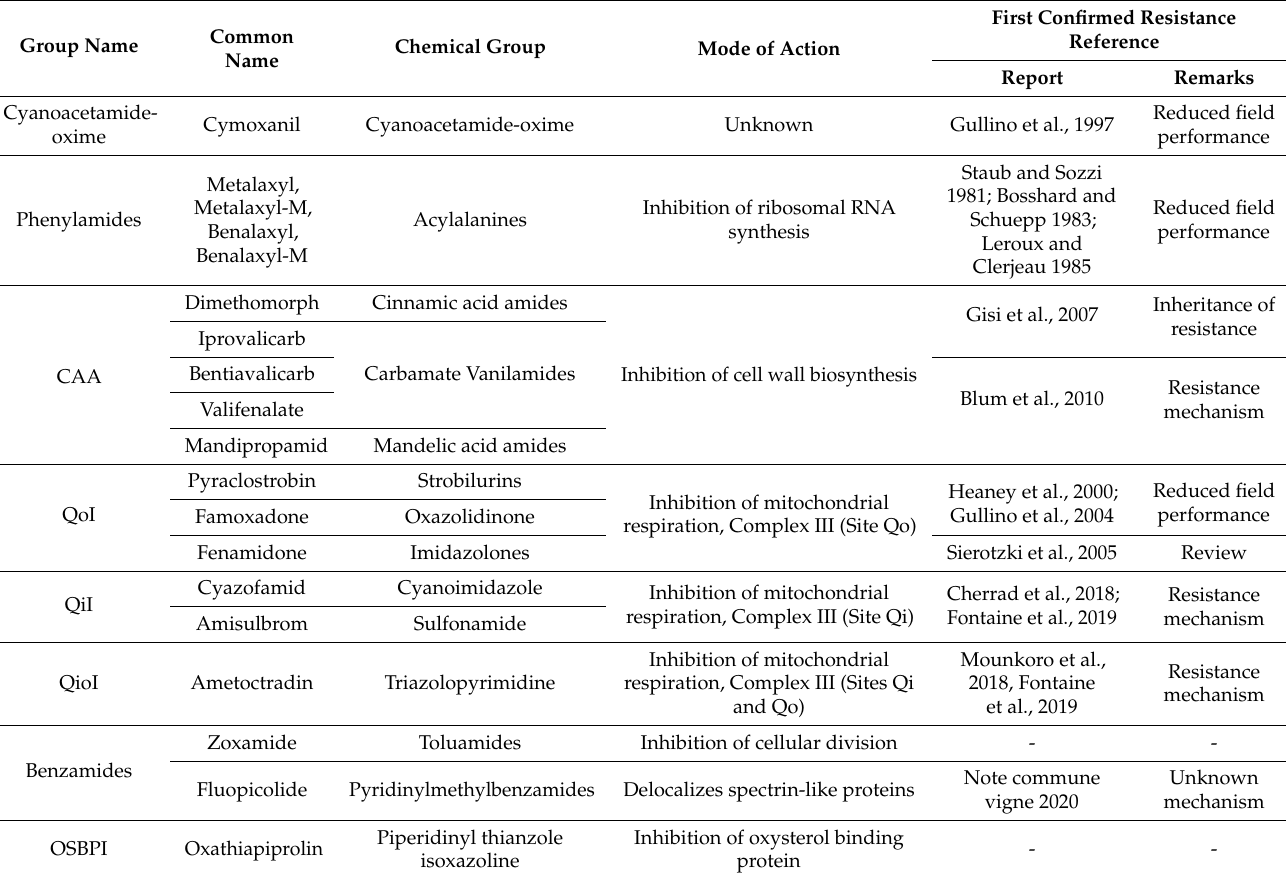
Table 1. List of antiperonosporic single/oligo-site active ingredients divided by chemical group, mechanism of action, and resistance reference. “CAA”, Carboxylic Acid Amide; “QoI”, Quinone outside Inhibitor; “QiI”, Quinone inside Inhibitor; “QioI”, Quinone inside-outside Inhibitor; “OSBPI”, Oxysterol-Binding Protein; ”-“not